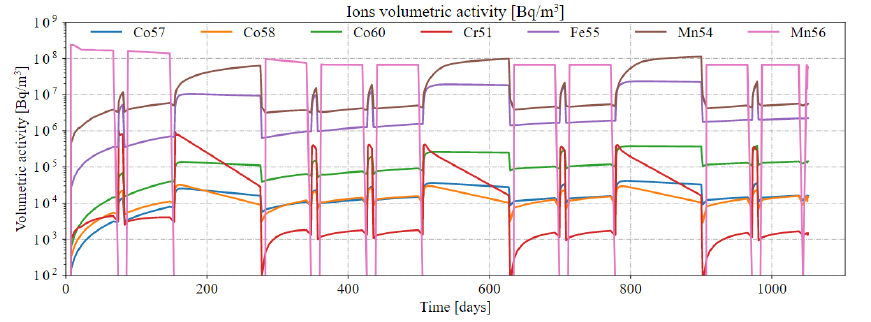
Figure 8. EU-DEMO Divertor cassette PHTS activities of ions in solution.